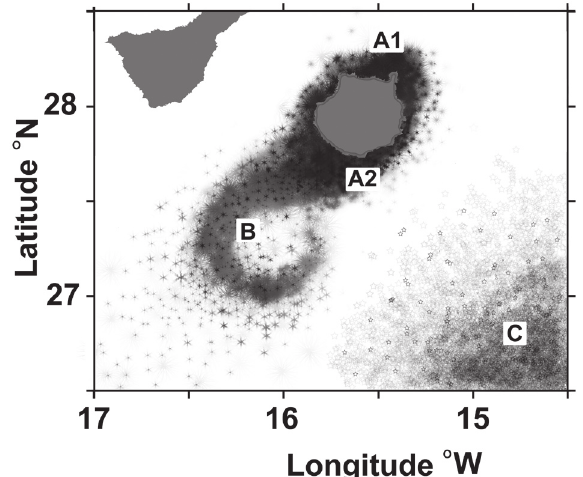
Fig . 7. – Proposed mechanisms for the physical-biological coupling in the field around gran canaria. a, High larval retention zone as- sociated with the island shelf (a1, stagnation area upstream of the island; a2, stagnation area in the warm lee downstream); B, moder- ate retention zone related to the cyclonic eddy; c, zone of african larvae transported by the upwelling filament